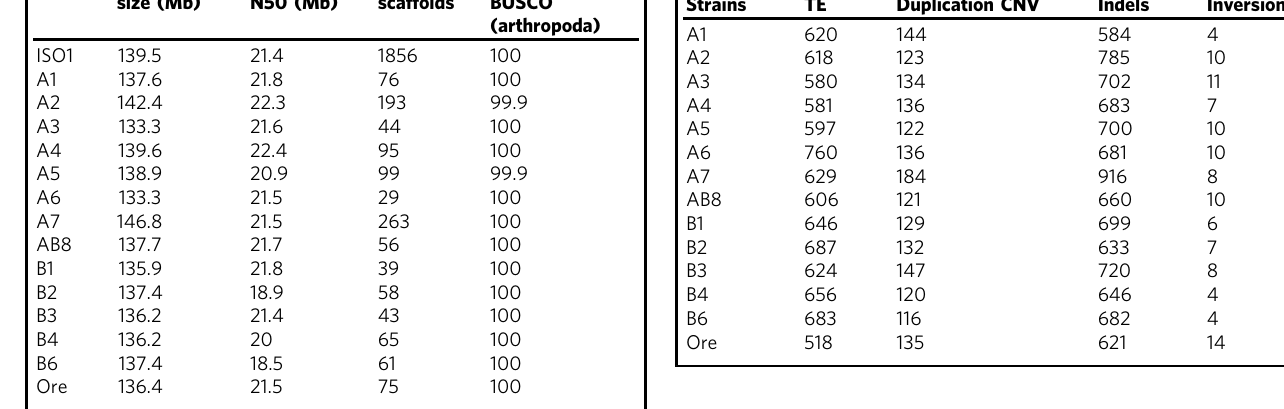
N50 = sequence length such that 50% of the assembly is contained within sequences of that length or longer BUSCO = Benchmarking Universal Single Copy Orthologs